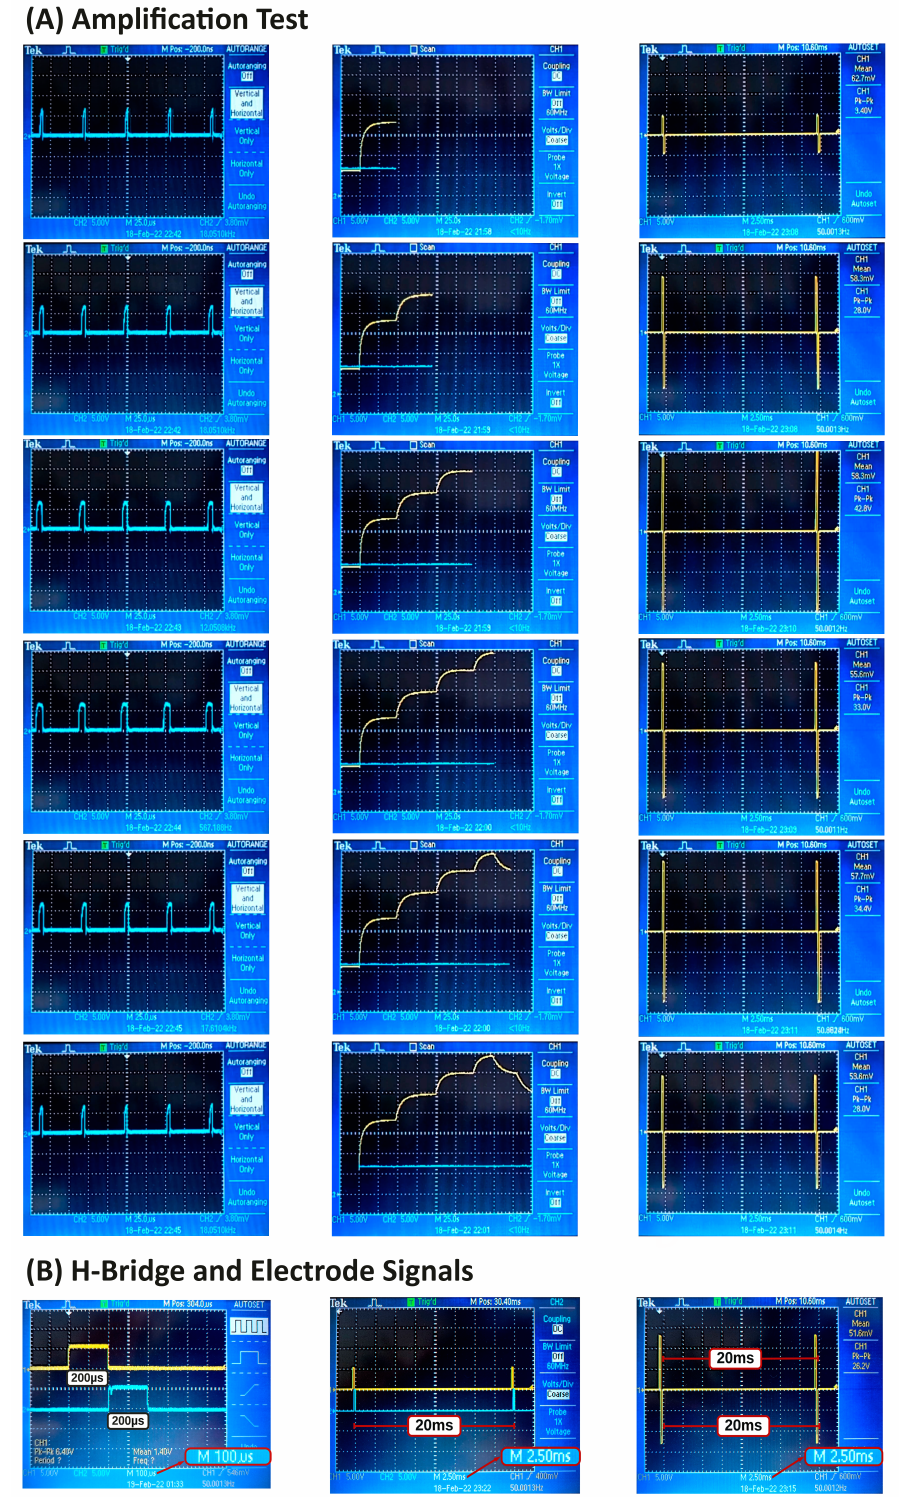
Figure 7. Structural Hardware Test. The figure shows the results of the structural test using an oscilloscope. ( A ) First column: PWM input to the Boost Control and H-Bridge. Second column: BC response to the PWM input signal. Third column: H-Brige response to the modulation signal. ( B ) Left: Two-channel BC response to PWM signal in 100 µ s window. Center: The 2.5 ms reading window of the Two-channel BC. Right: The stimulation signal sent to the electrode.